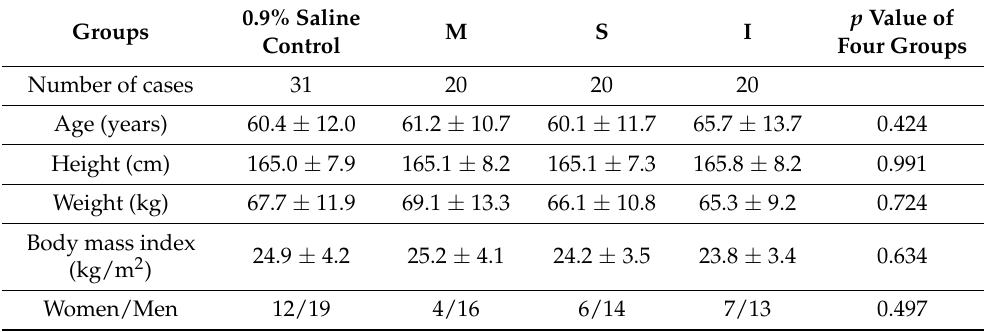
Table 1. Demographic characteristics of recipients in 0.9% saline control and groups M, S, and I. Groups